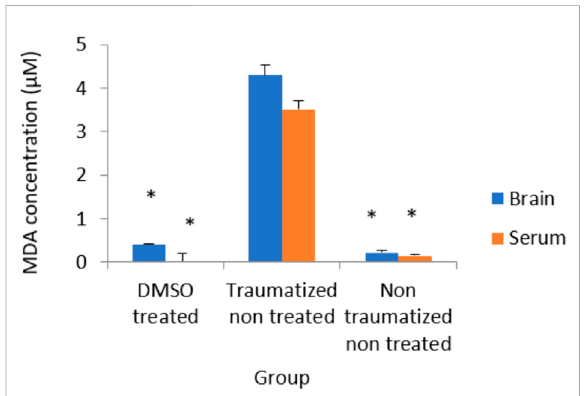
FIGURE 10 Effects of DMSO on the Activity of serum and brain cortex MDA in TBI induced rats; DMSO- dimethylsulfoxide, TNT- Traumatized Non-Treated, NTNT – Non traumatized non-treated. Data are expressed as the mean ± S.D. n = 5 per group. Data analyses were conducted using a one-way analysis of variance (ANOVA). Post hoc analyses were performed using Tukey ’ s multiple comparison tests when appropriate. * p < 0.05 compared to the traumatized non-treated and non-traumatized non-treated groups.